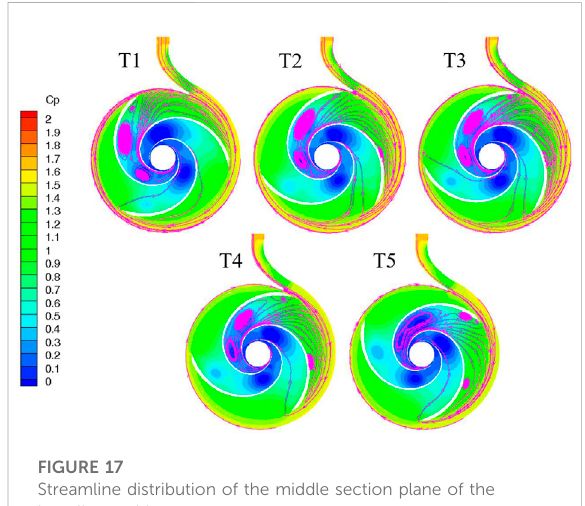
Streamline distribution of the middle section plane of the impeller